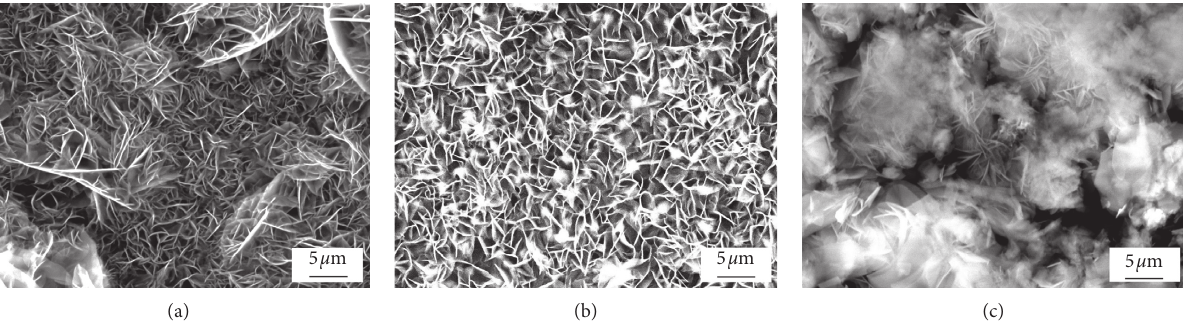
Figure 12: SEM images after (a) 360hrs of immersion, (b) 720hrs of immersion, (c) 1200hrs of immersion in 0.1M NaCl solution.